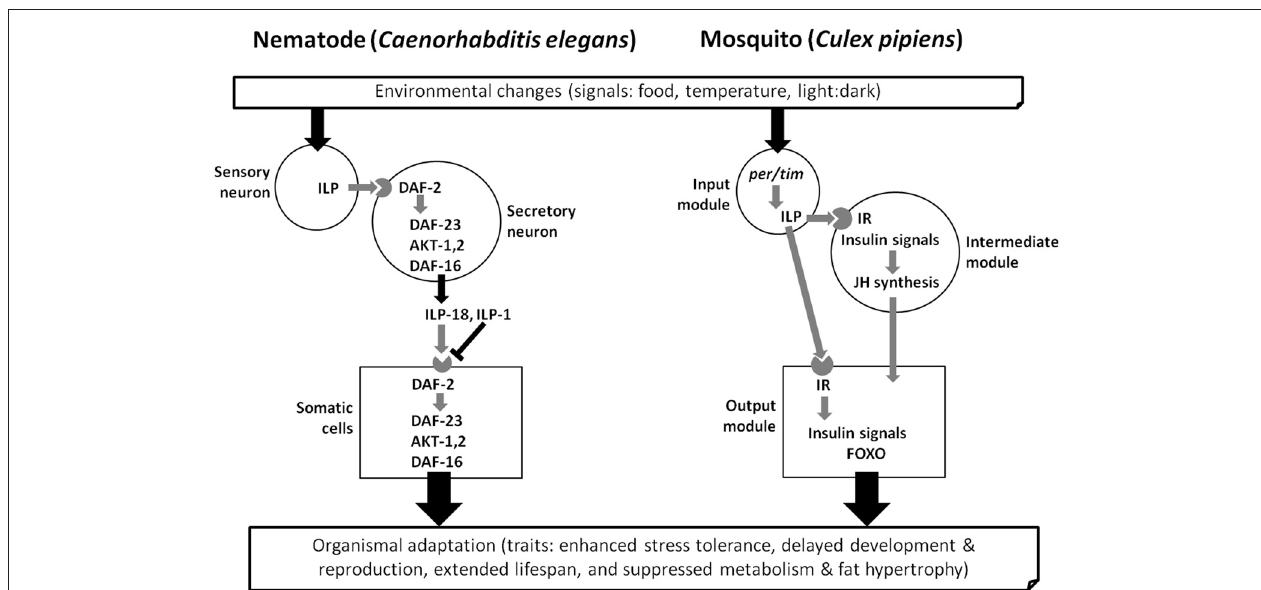
FIGURE 1 | Three conceptual modules (input, intermediate and output) that influence dauer larva formation in the nematode Caenorhabditis elegans and adult diapause of the mosquito Culex pipiens , based on references in the text. Gene activation (Black) and deactivation (Gray). Insulin-like peptide, ILP; DAF-2, insulin receptor